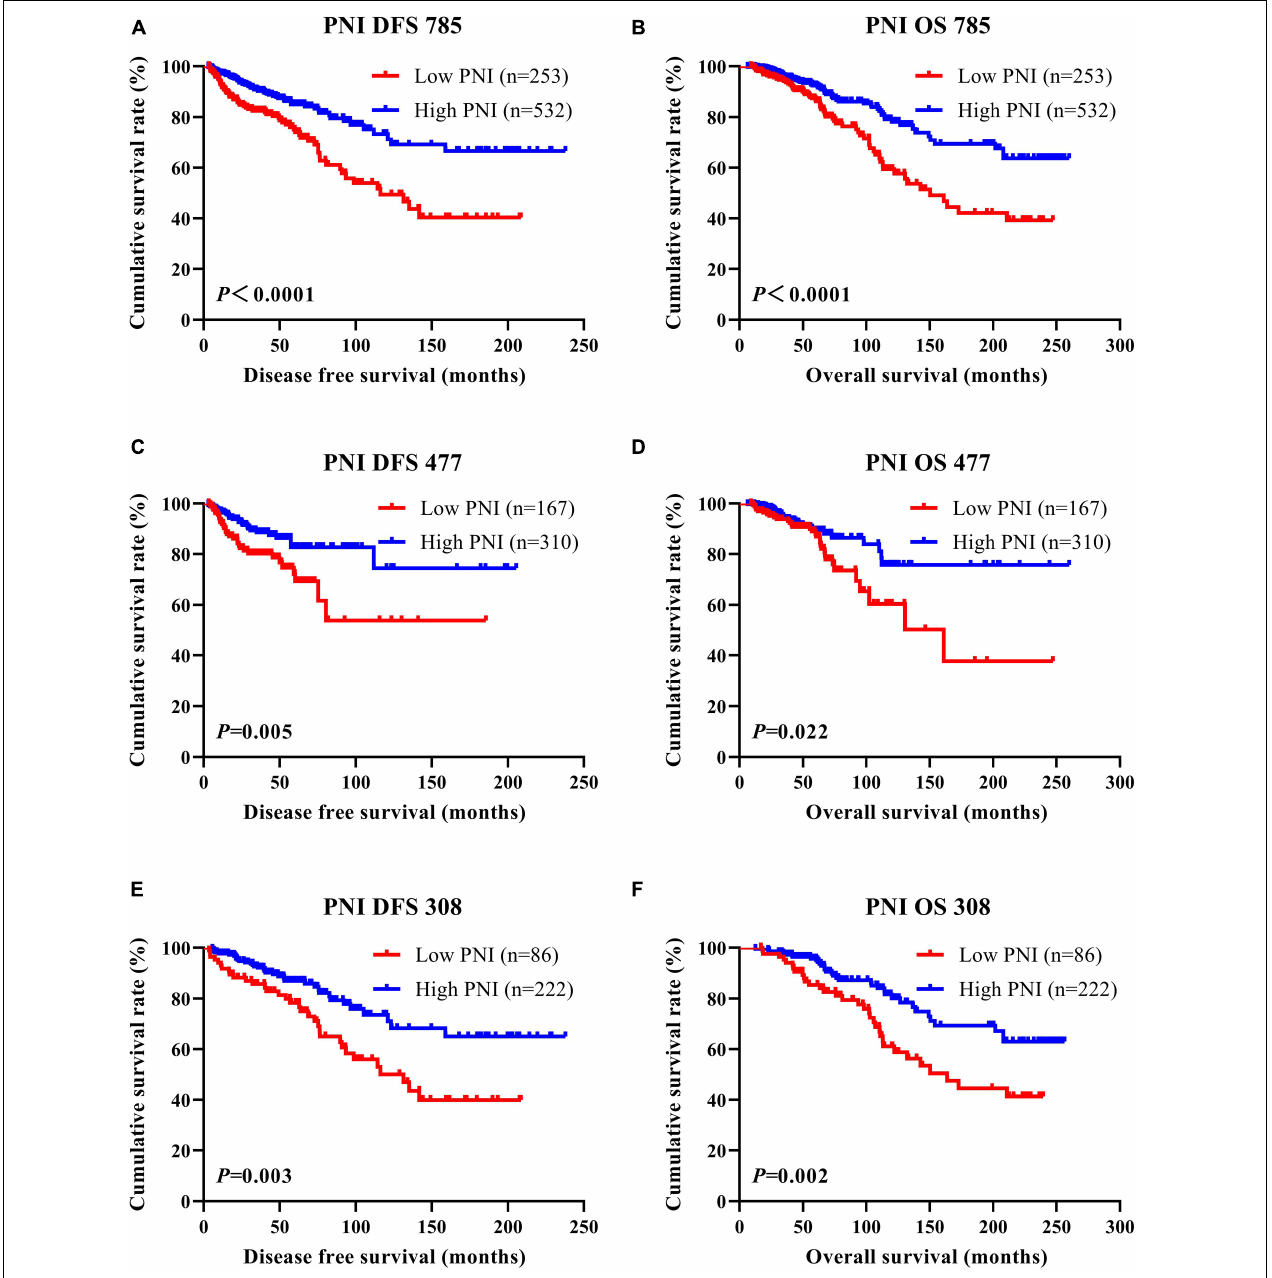
FIGURE 1 | Disease-free survival (DFS) and overall survival (OS) of patients with breast cancer. (A,B) Kaplan–Meier analyses of DFS (A) and OS (B) for the prognostic nutritional index (PNI) of all patients with breast cancer. (C,D) Kaplan–Meier analyses of DFS (C) and OS (D) for the PNI of patients with breast cancer